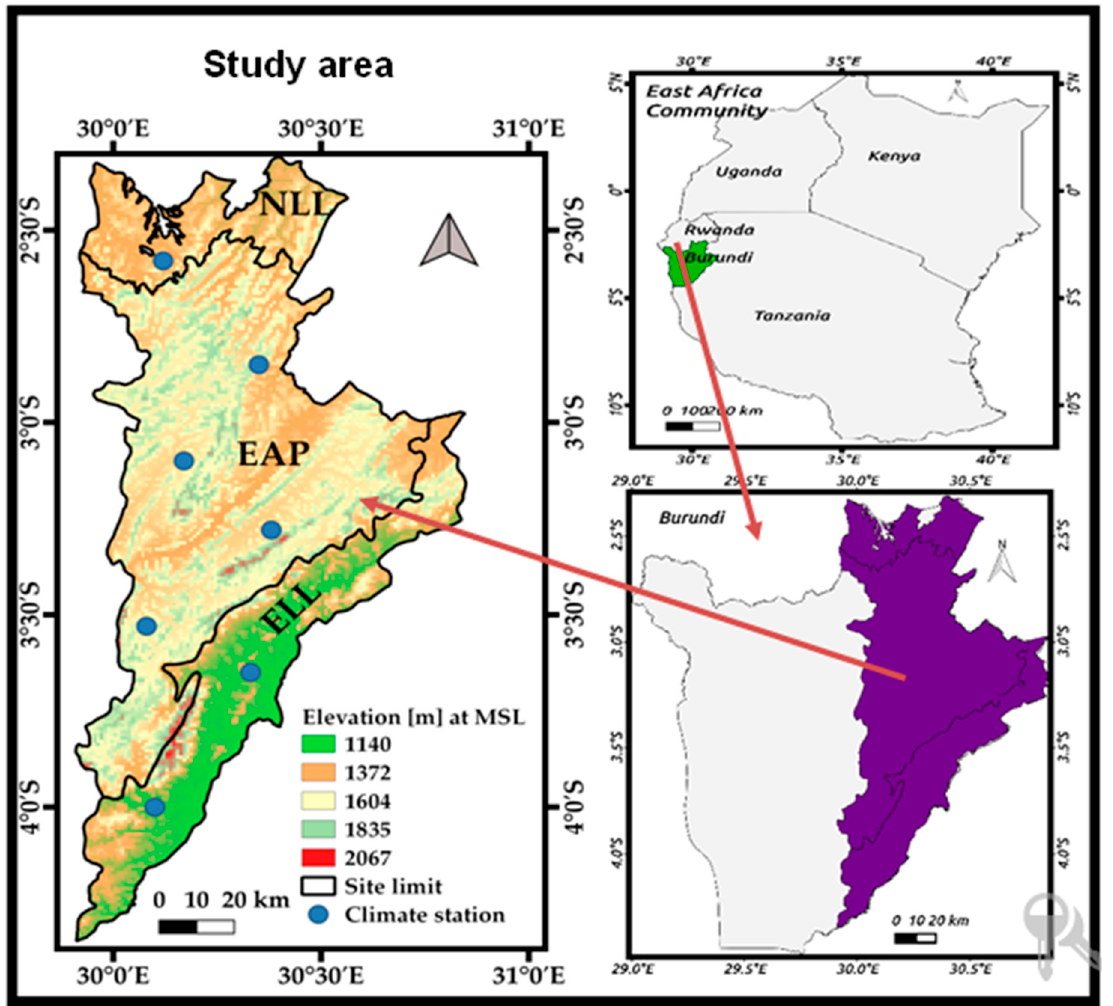
Figure 1. Study area location.